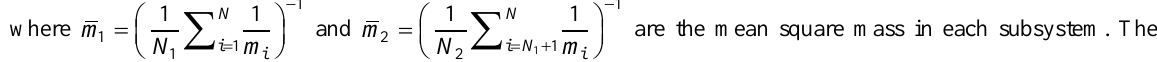
are the mean square mass in each subsystem.